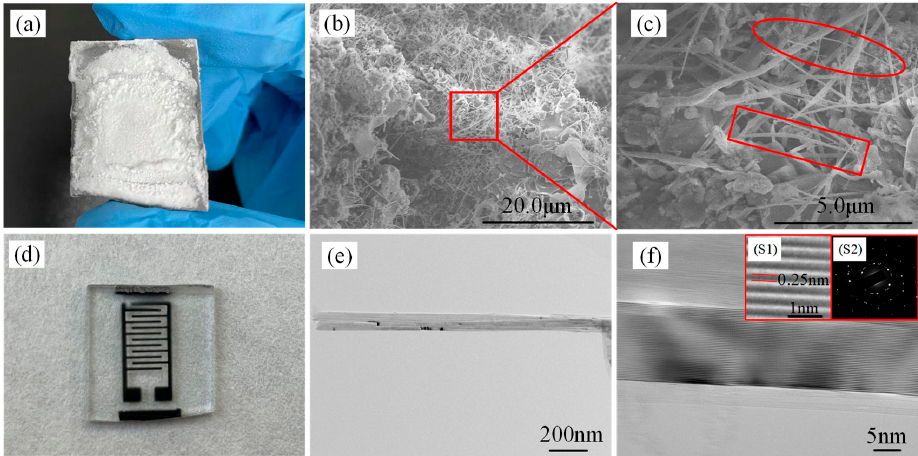
Figure 1. ( a ) BNNRs prepared by CVD method. ( b ) SEM image of BNNRs. ( c ) Typical magnified SEM images of the selected surface area. ( d ) The DUV detector based on BNNRs. ( e ) TEM image of BNNRs. ( f ) Lattice fringes (S1: Lattice fringes magnified locally. S2: Diffraction pattern).